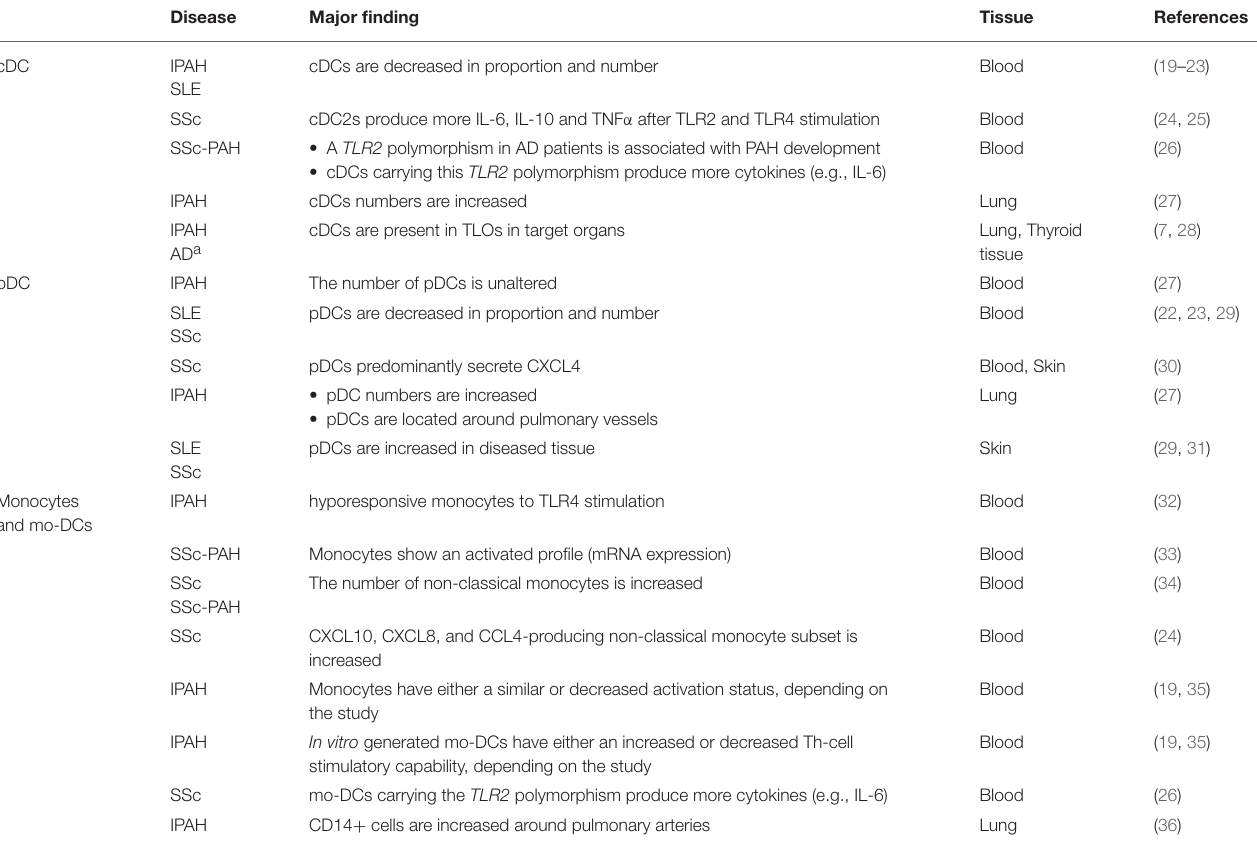
TABLE 1 | Involvement of DCs and monocytes in IPAH, AD, and